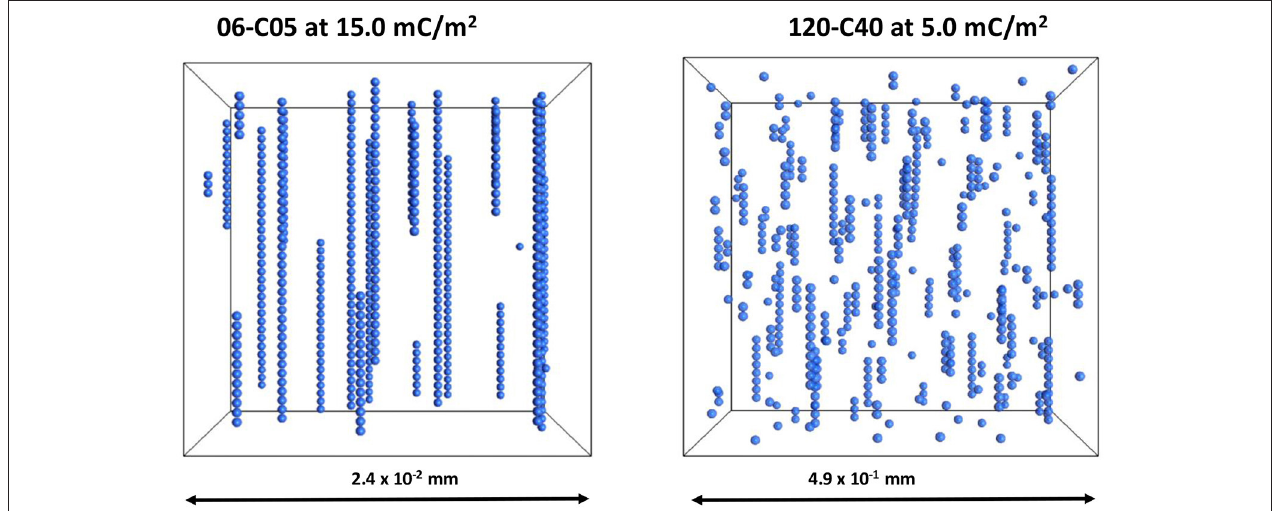
FIGURE 9 | Visualization of the cases 06-C05 and 120-C40 at 15 and 5 mC/m 2 . These cases have relative shell thickness of 0.17 and 0.67. The images have been scaled for easier viewing. However, the dimensions of the system were different to keep a constant volume fraction of